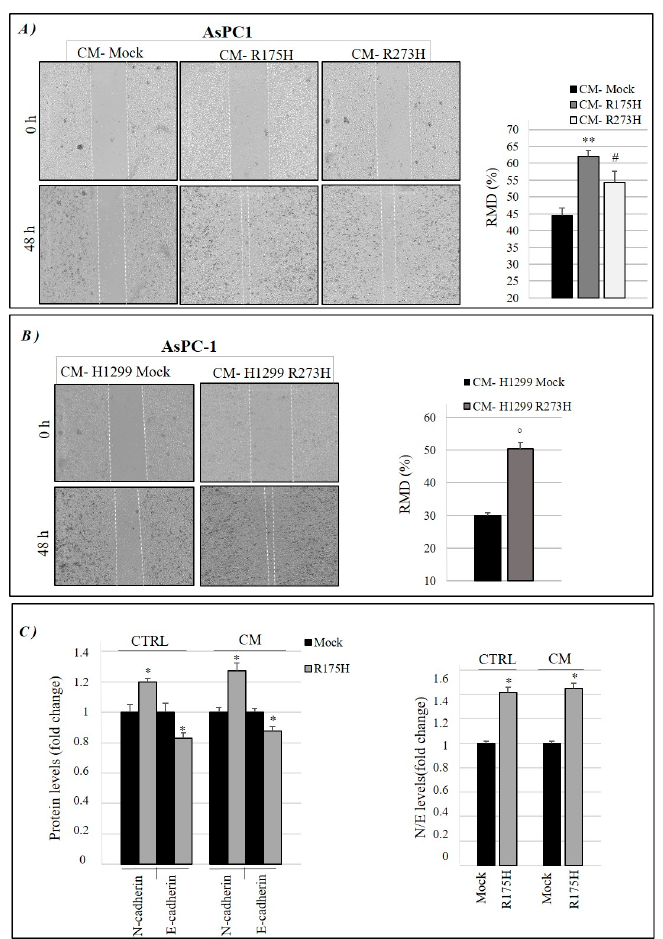
Figure 3. Mutp53-driven secretome stimulates cancer cell migration and epithelial-mesenchymal transition (EMT). ( A ) Wound closure cell assay on the confluent p53-null AsPC-1 cell monolayer that